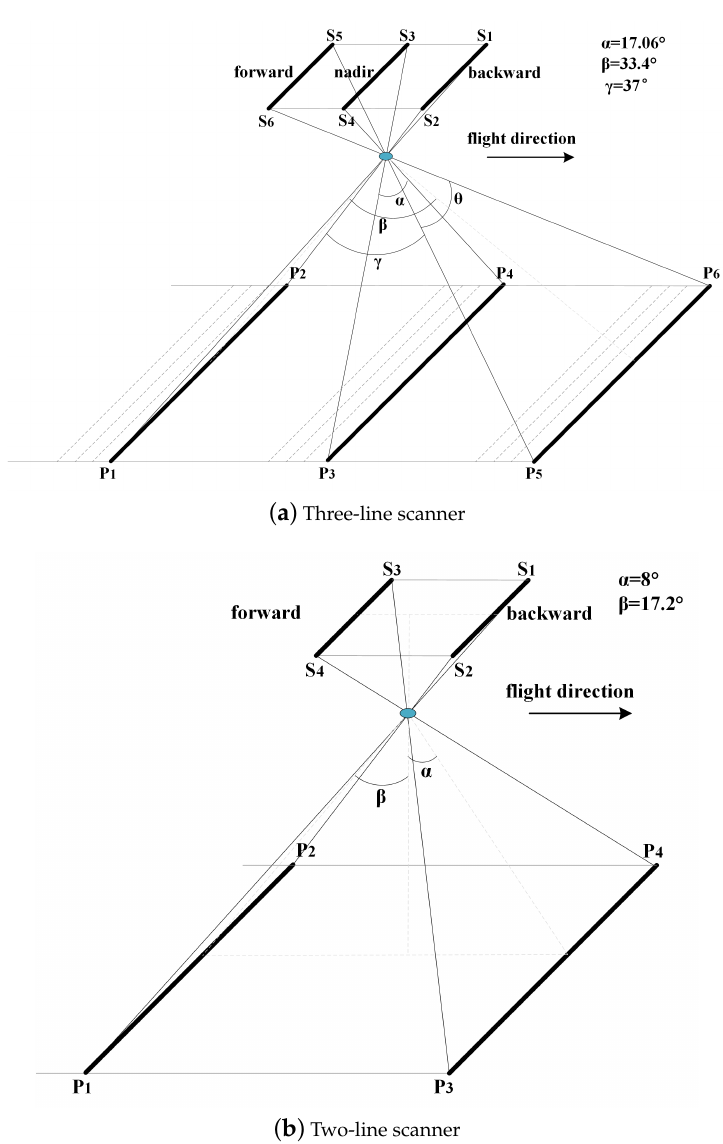
Figure 1. The push boom scanners equipped on ( a ) Chang’E-1 and ( b )